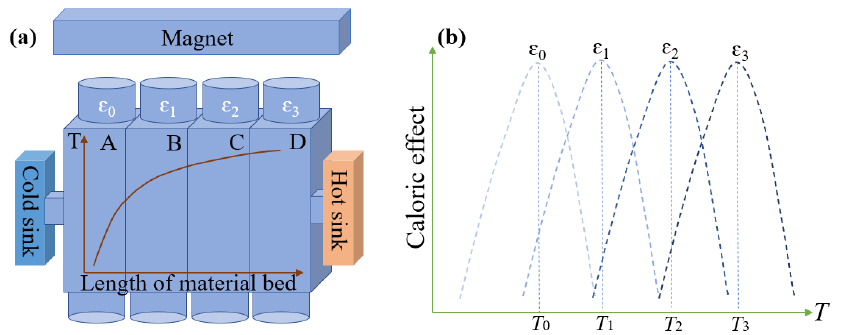
Figure 5. ( a ) The schematic diagram of the temperature gradient in the material bed, where the temperature gradient is displayed, where T indicate the temperature of the refrigerates and A, B, C, D indicate refrigerants at four different positions in the material bed. ( b ) The optimal working temperature of refrigerants tuned by the uniaxial strain.